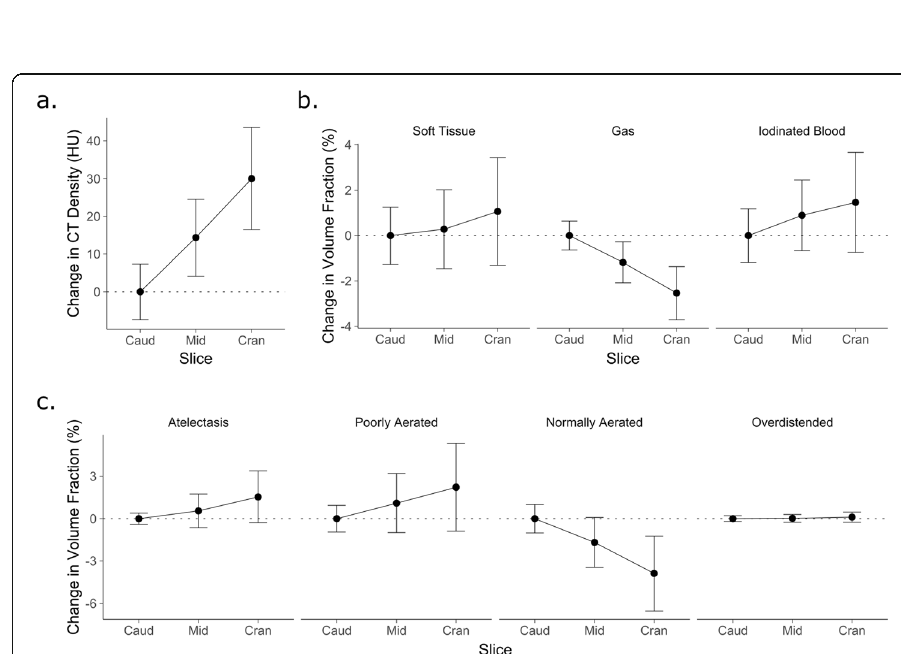
Fig. 4 Variation in the means of eight studied variables between three adjacent 5-mm juxtadiaphragmatic dynamic CT slices acquired concurrently. Values are presented relative to the mean value in the most caudal slice. a Mean slice density, b results of the three-material differentiation and c following segmentation based upon gas density. A good correlation was seen between cranio-caudal position and CT density, gas and normally aerated volume fractions. Points and error bars represent mean and SD of 13 – 16 frames (dependent on exclusion of frames mid-way between expiration and inspiration) in 12 ventilatory conditions in 8 animals. Caud caudal slice, Mid middle slice, Cran cranial